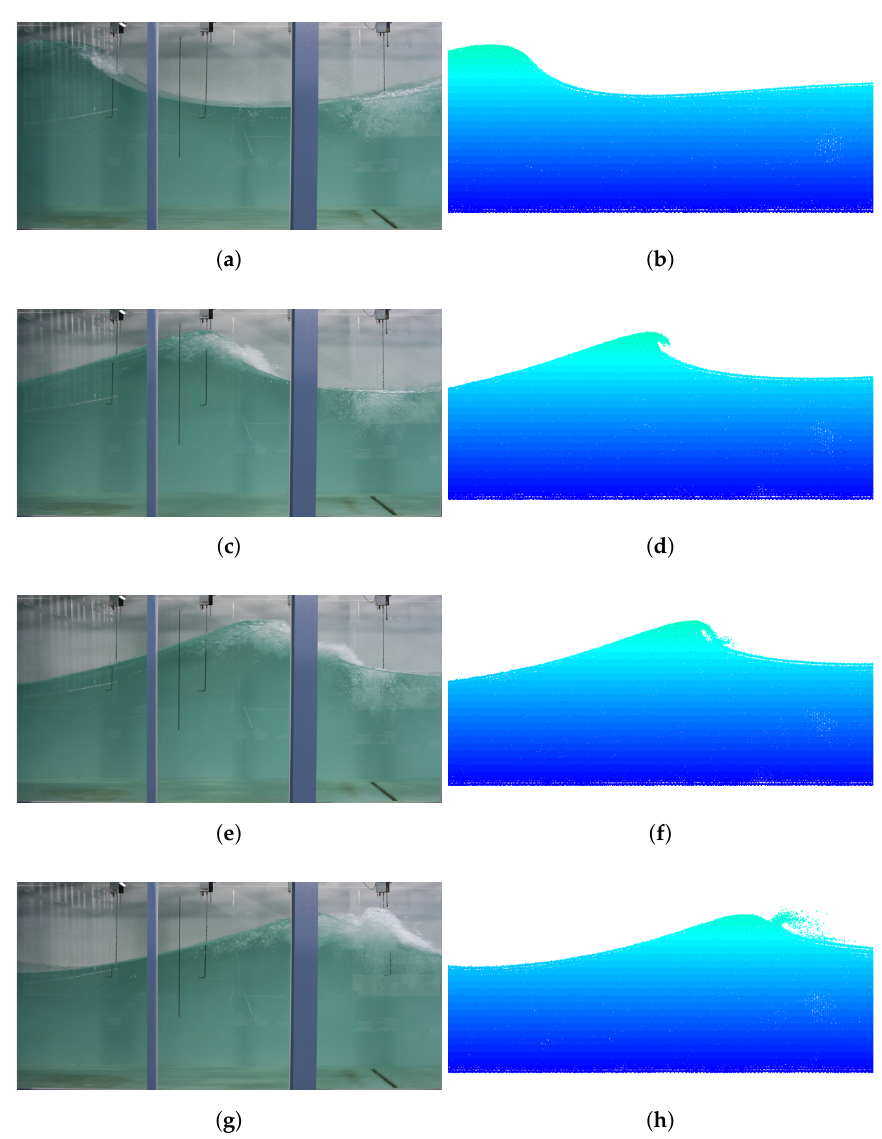
Figure 15. Comparison of the breaking waves in experiments (left) and numerical simulations (right) of Case VI-1.